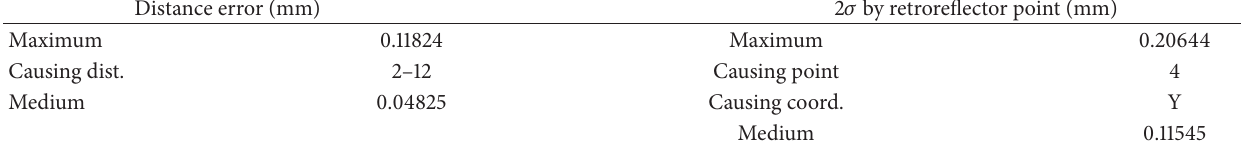
Table 5: Quality indicators for the identified values of model parameters over 21 SMR locations (105 AACMM positions).